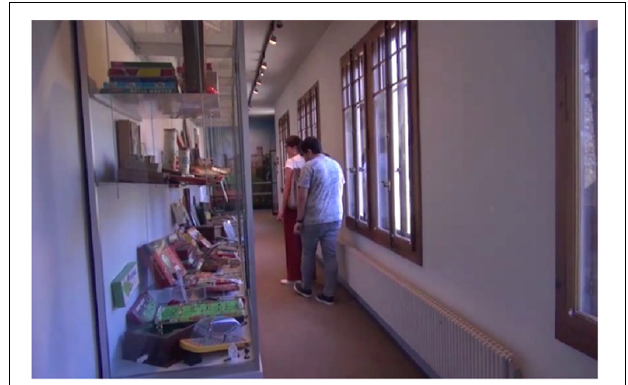
FIGURE 19 | Front-to-back